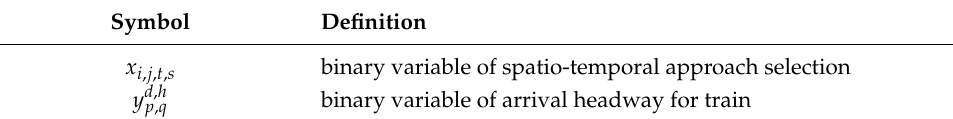
Table 2. Decision